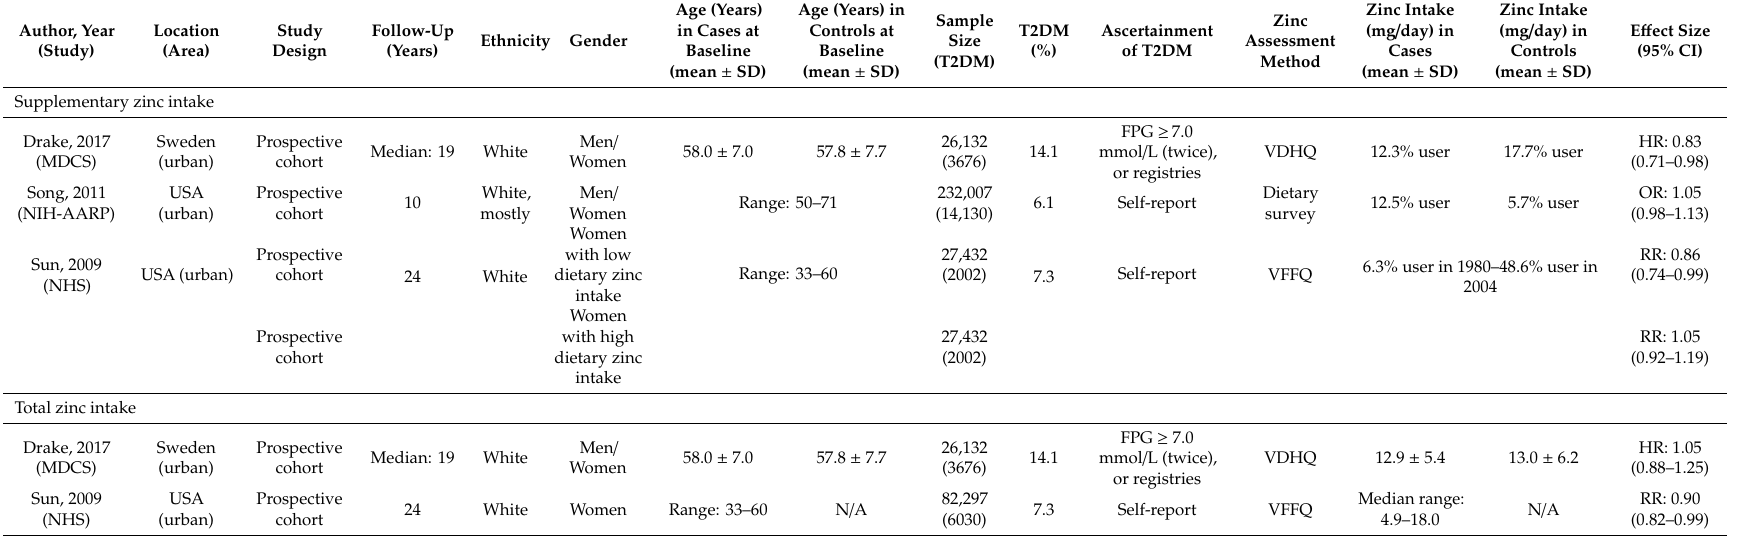
Table 2. Characteristics of studies reporting the association between supplementary and total zinc intake and risk of type 2